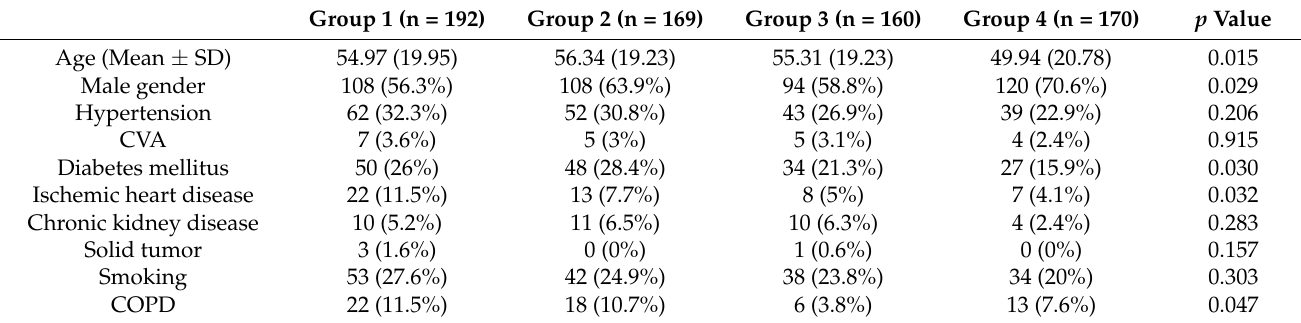
Table 1. Demographic and clinical characteristics of the patients according to the duration of invasive mechanical